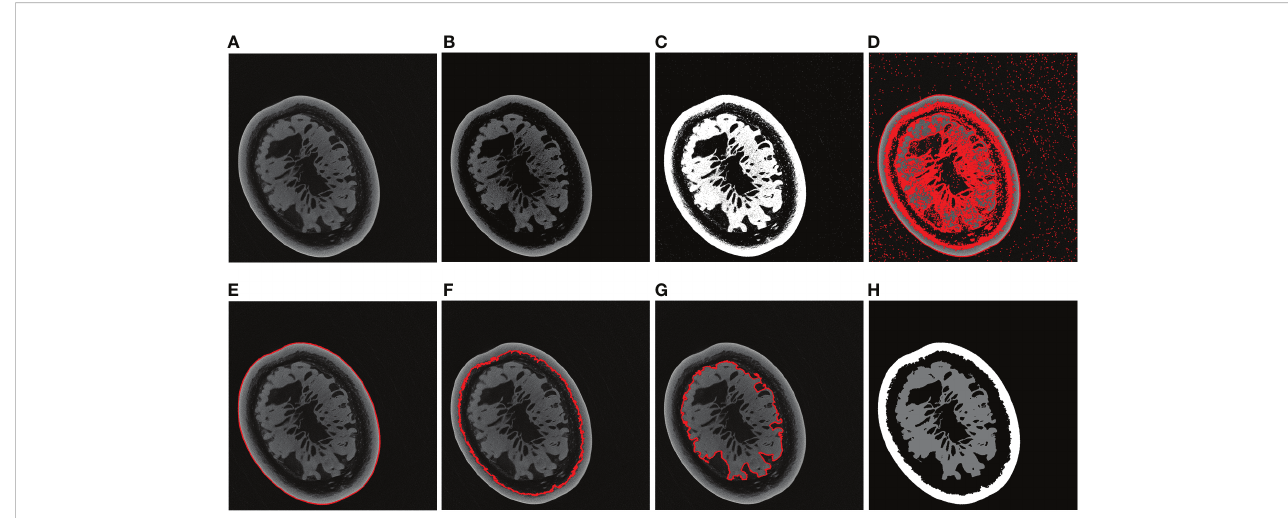
FIGURE 5 Label generation processing. (A) Example of a tomogram image. (B) After grayscale transformation. (C) Otsu segmentation result. (D) All contours. (E) Largest contour. (F) Second-largest contour. (G) Third-largest contour. (H) Label of the original